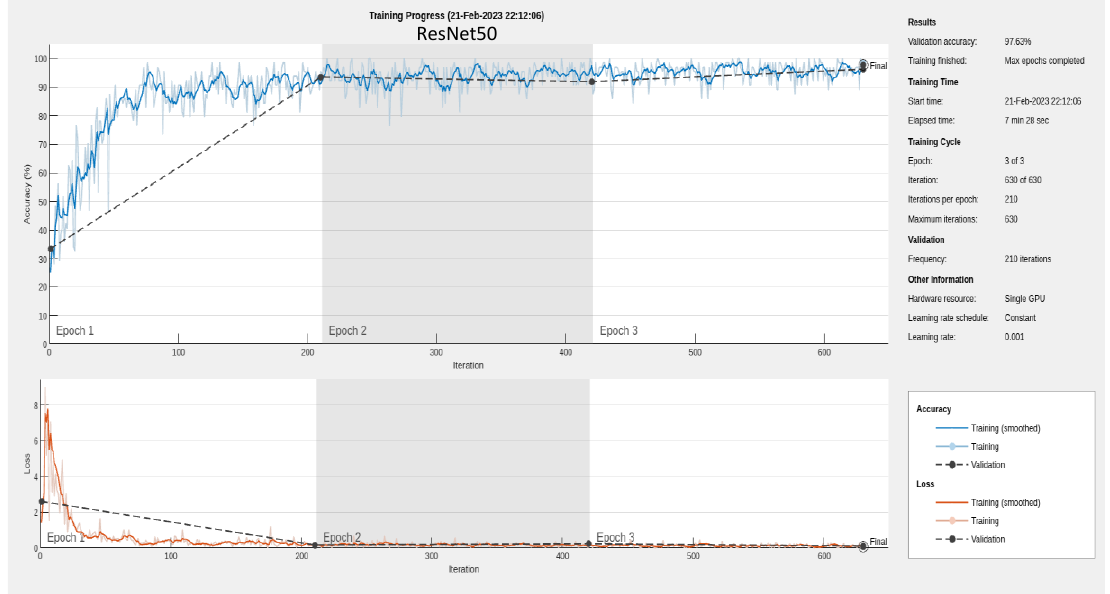
Figure 9. Accuracy and loss of training progress in the ResNet50 transfer learning from scratch (no transfer learning).